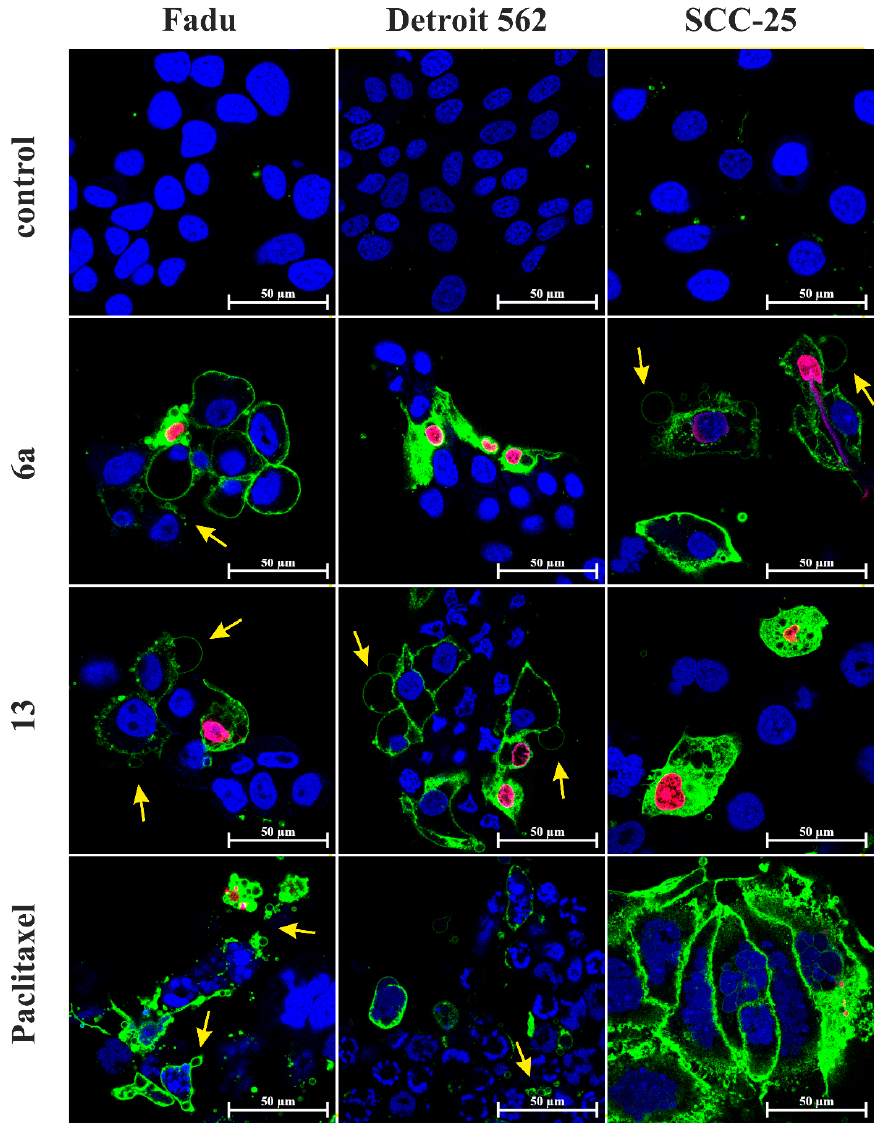
Figure 6. Apoptosis-necrosis detection assay on Fadu, Detroit 562 and SCC-25 HNSCC cells by confocal laser scanning microscopy. The cells were treated for 28 h at 2.5 μ M. Paclitaxel was used as a positive control and untreated cells as a negative control. Nuclei were visualized by membrane-permeable dye DRAQ5 (blue). CF488A-labeled Annexin V stains apoptotic cells with green fluorescence. Membrane-impermeable Ethidium Homodimer III stains the nuclei of necrotic cells and late apoptotic cells exclusively (pink color). Plasma membrane blebs are marked with yellow arrows.